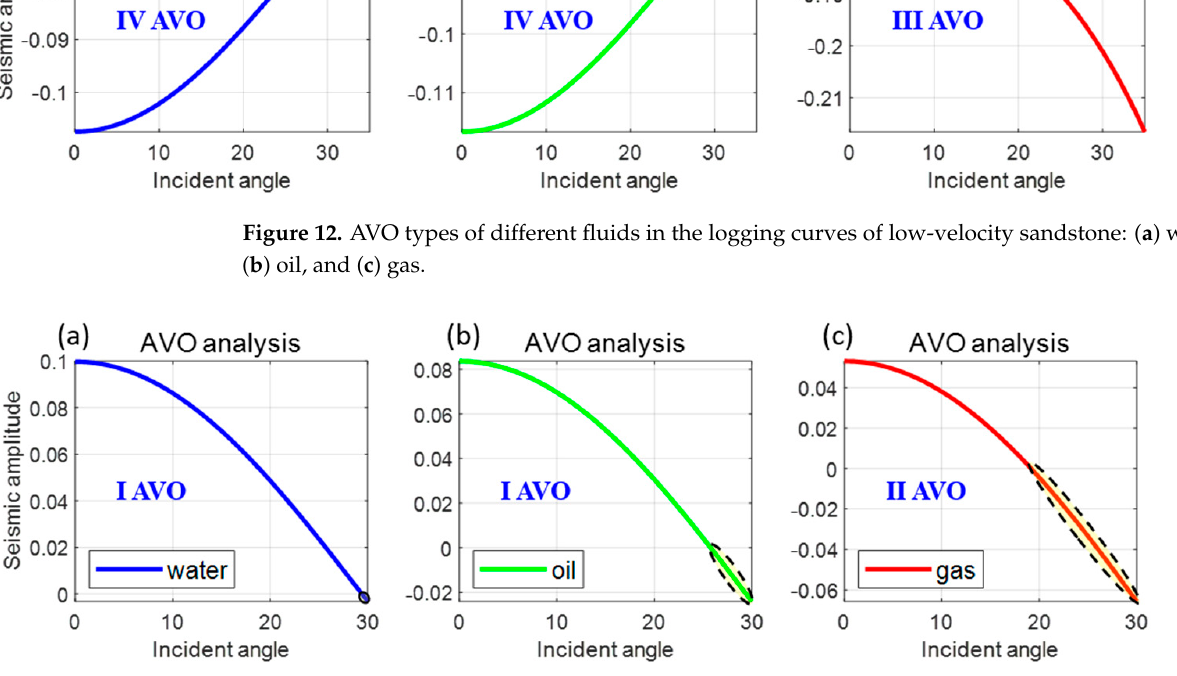
Figure 13. AVO types of different fluids in the logging curves of high-velocity sandstone: ( a ) water, ( b ) oil, and ( c ) gas.